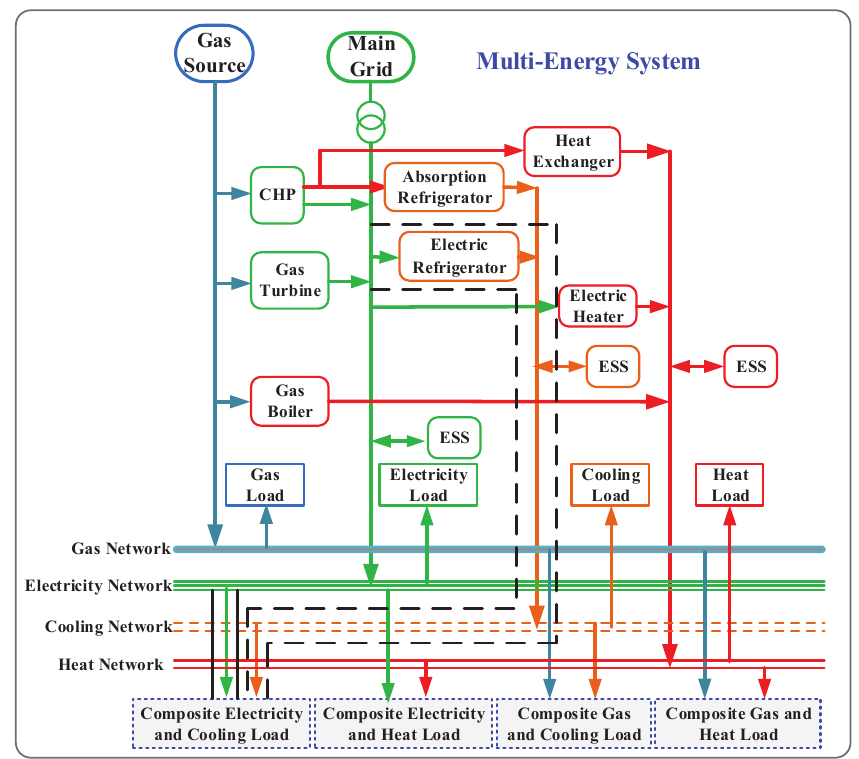
Figure 5. Redundant conversion path of electricity-cooling load in Scenario